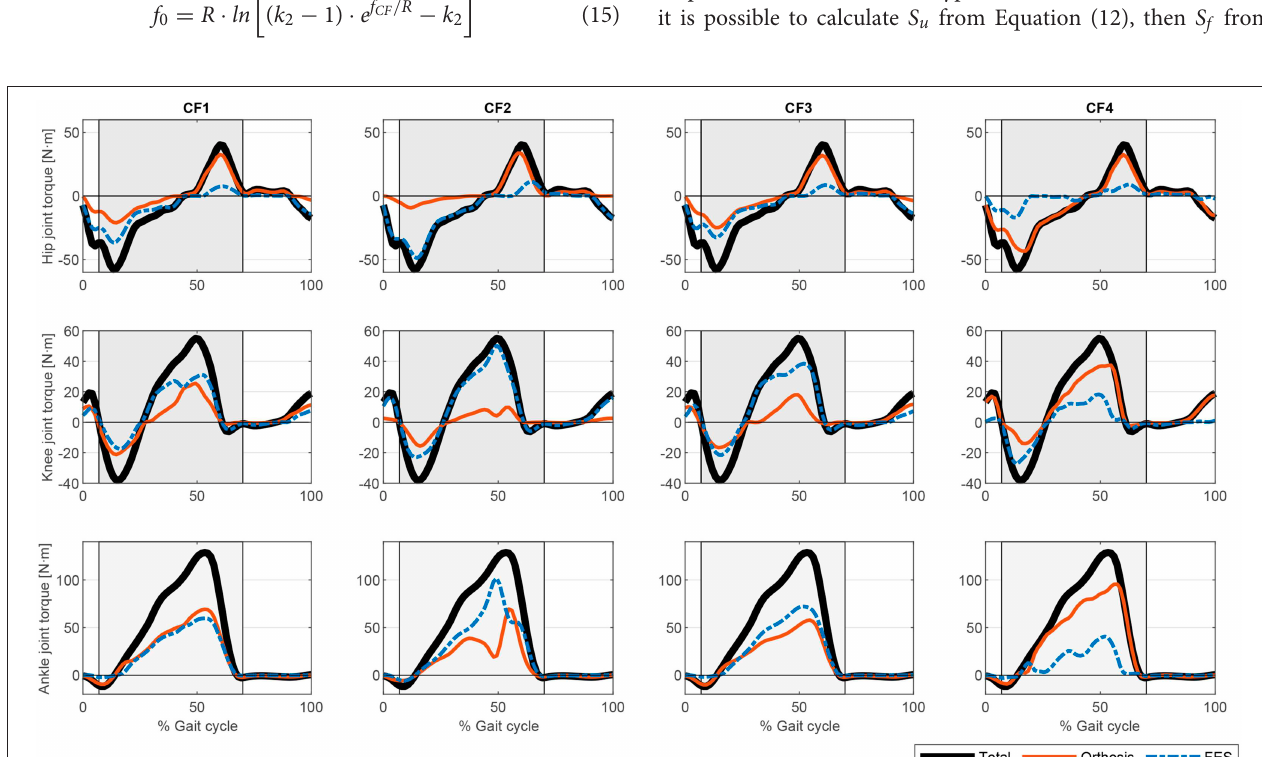
FIGURE 3 | Comparison of the different torque profiles for the proposed optimization cost functions.